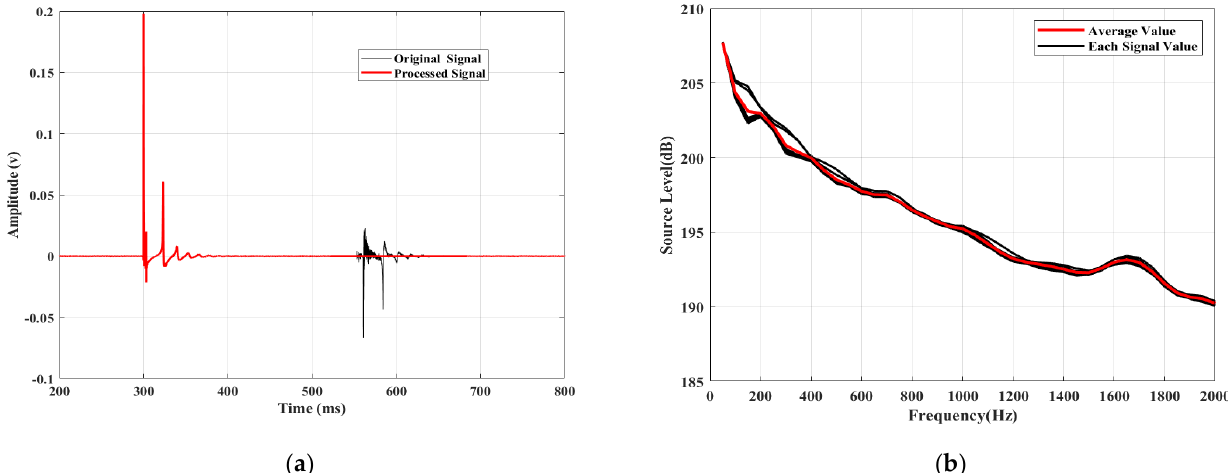
Figure 5. ( a )The signal of source level and ( b ) the curve of sound source level with frequency 50–2000 Hz (interval 50 Hz).